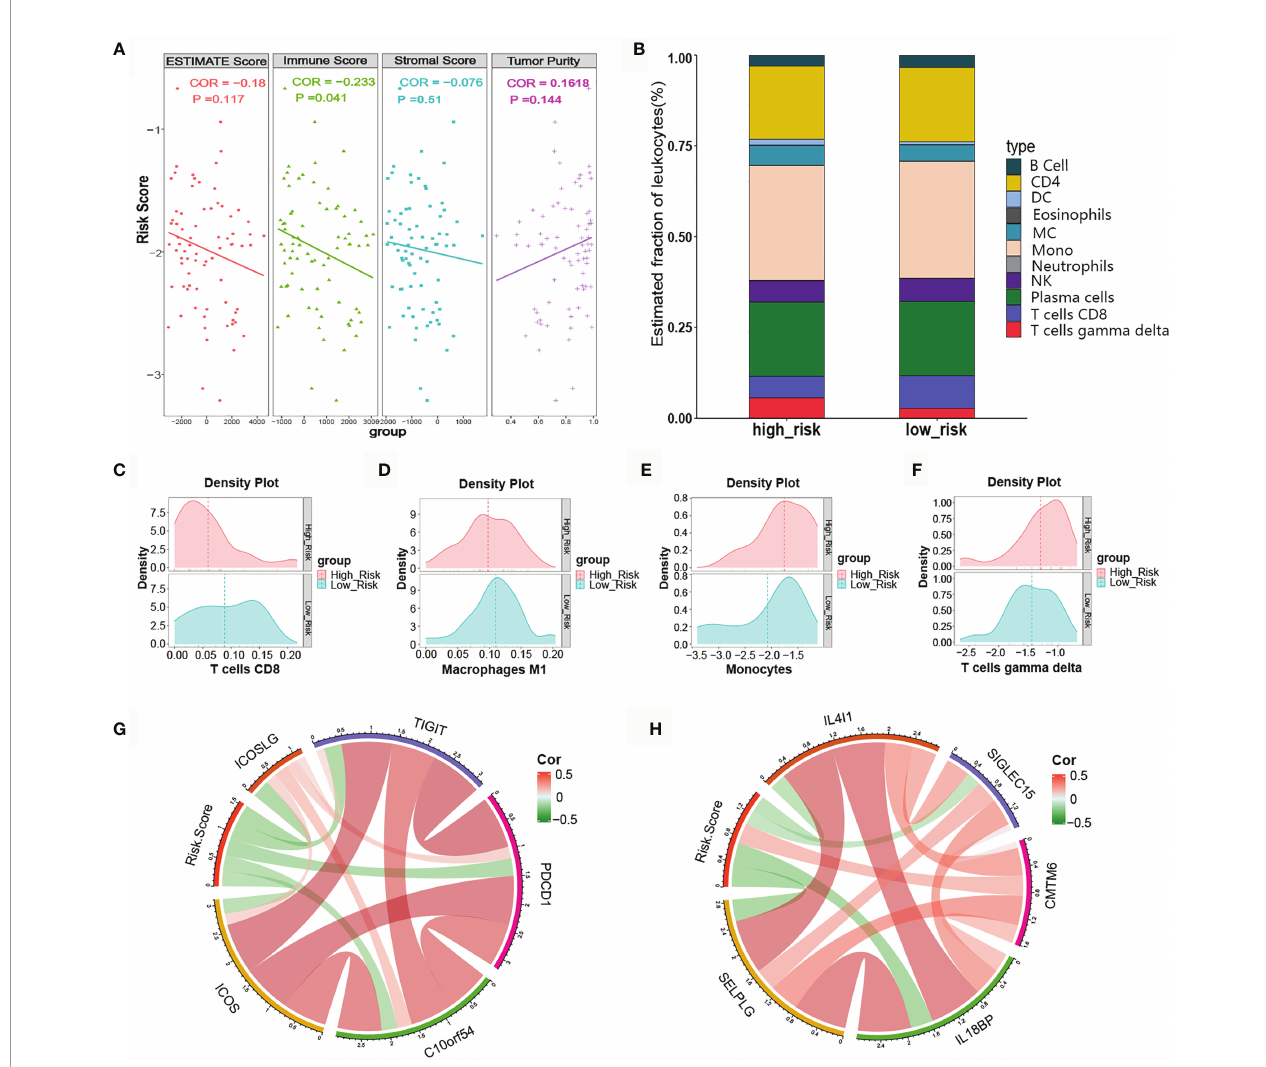
FIGURE 7 | Relationship between the risk score and tumor-in fi ltrating immune cells as well as immune checkpoints. (A) ESTIMATE score, immune score, stromal score, and tumor purity in high- and low-risk patients. (B) Difference in tumor-in fi ltrating immune cells between the high- and low-risk groups. (C-F) Difference in immune cell in fi ltration abundance between the high- and low-risk groups. (G, H) Correlation chord chart showing the correlations between risk scores and other immune checkpoint